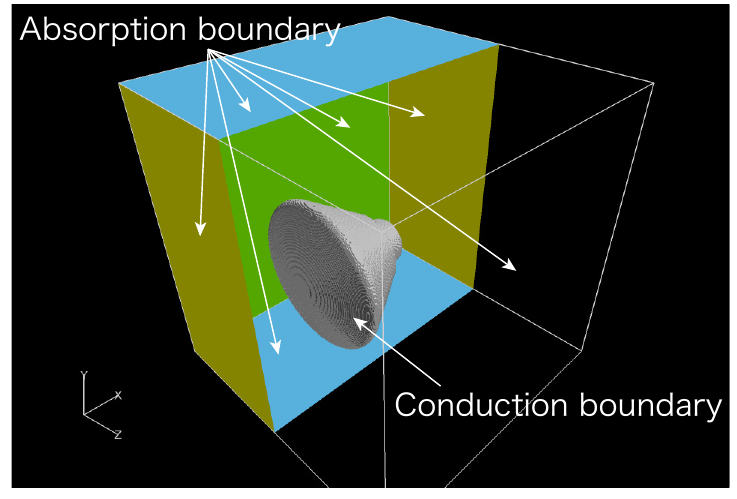
Figure 6. Computational domains and boundary conditions around the ESA ARD for plasma flow